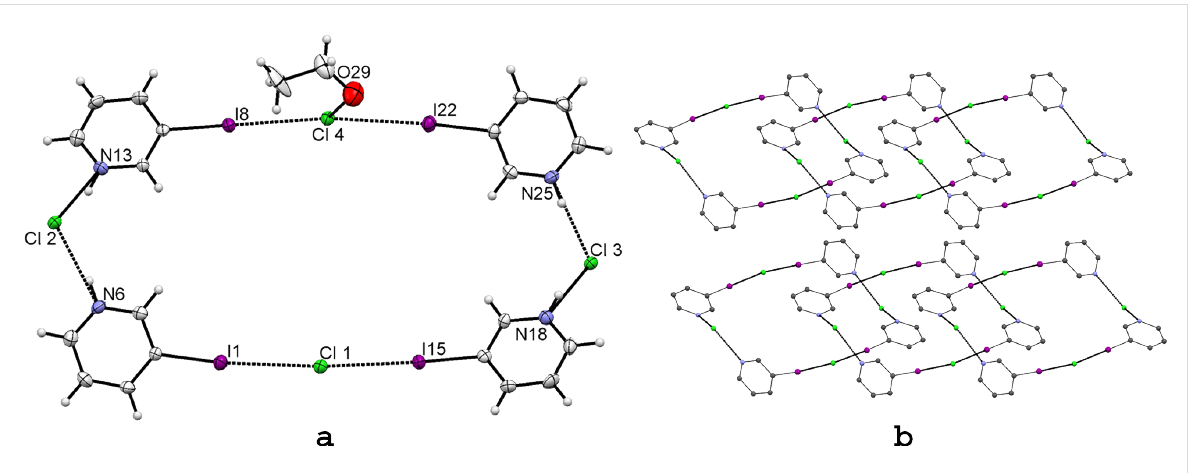
Figure 6: X-ray structure of 3-IPyHCl ( 10 ) with the selected numbering scheme of the asymmetric unit (a) and packing scheme viewed down the crys- tallographic c axis (b). Thermal ellipsoids are drawn at the 50% probability level. Hydrogen and halogen bonds are shown in dotted lines.